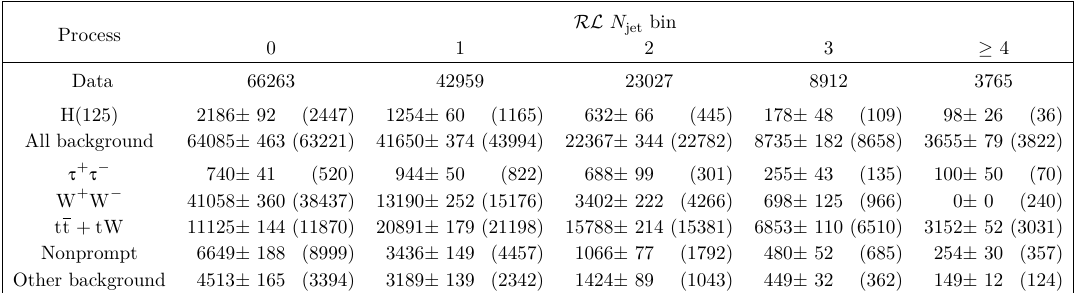
Table 6 . Signal and background post-fit (pre-fit) yields in the RL N